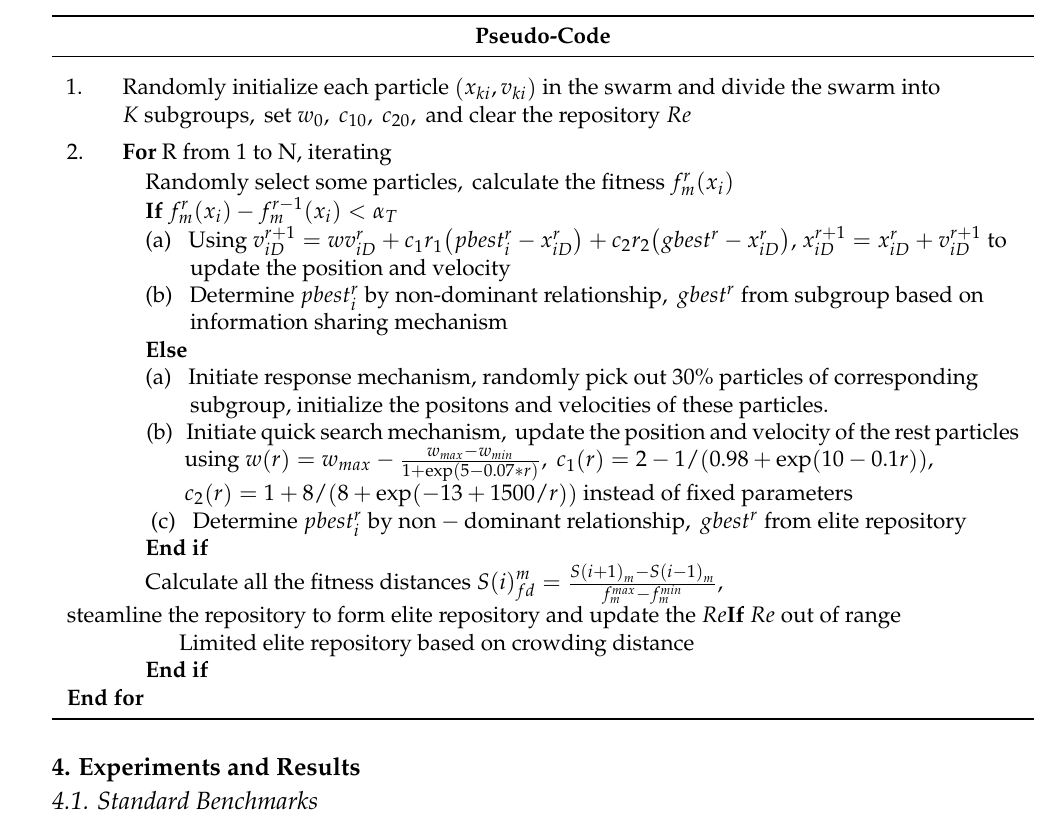
Table 1. The pseudo-code of the DVEPSO/FD